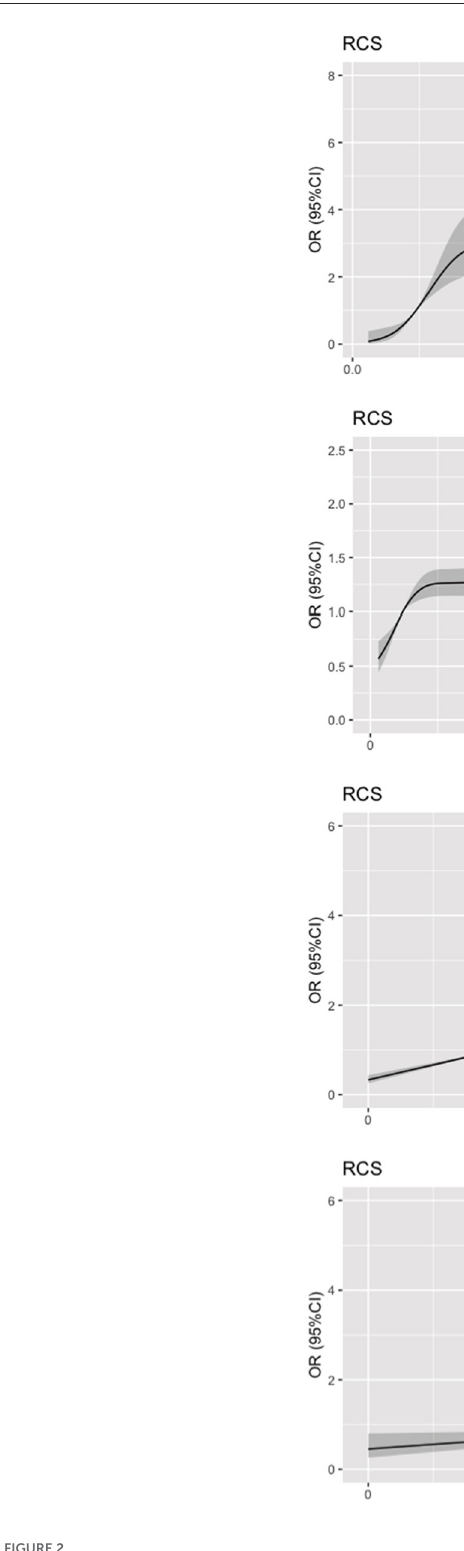
we further stratified the group of women by whether they were menopausal or not. In menopausal women, the ORs for the three LFSs were 1.26 (FIB-4), 1.37 (APRI), 1.54 (BAAT score), and 1.49